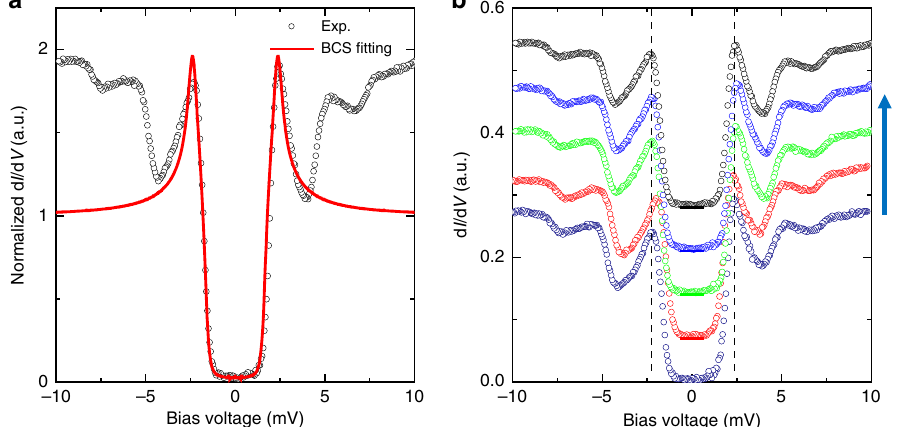
Fig. 3 Tunneling spectra with a full gap. a A tunneling spectrum with a full gap (black circles) measured at 0.35 K and the Dynes model fi t (red solid line). The gap function is Δ = 2.35(0.15cos4 θ + 0.85) meV in the fi tting. One can see that the data can be well fi tted with the Dynes model. Outside the coherence peaks, there are two side peaks at energies of about 5~6 meV. These might correspond to some bosonic modes. b Five spectra measured on the fi ve spots shown in Fig. 1c. All spectra show the similar behavior. Setting condition for a , b is V